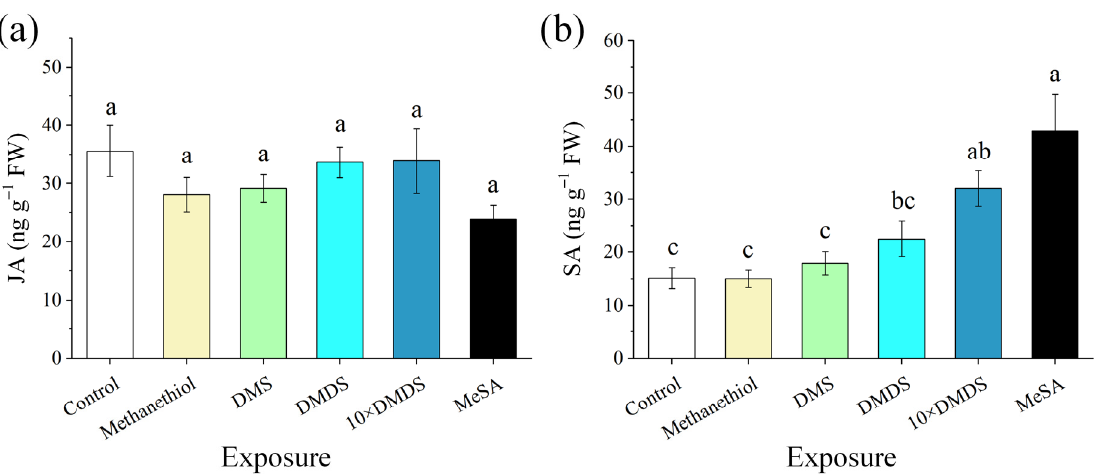
Figure 3. The levels of jasmonic acid (JA) and salicylic acid (SA) in orange plants after exposure to sulfur volatiles. ( a ) JA content; ( b ) SA content. Data are shown as means ± SE ( n = 5). Different letters on the columns indicate significant differences among different treatments based on Tukey’s test ( p < 0.05).